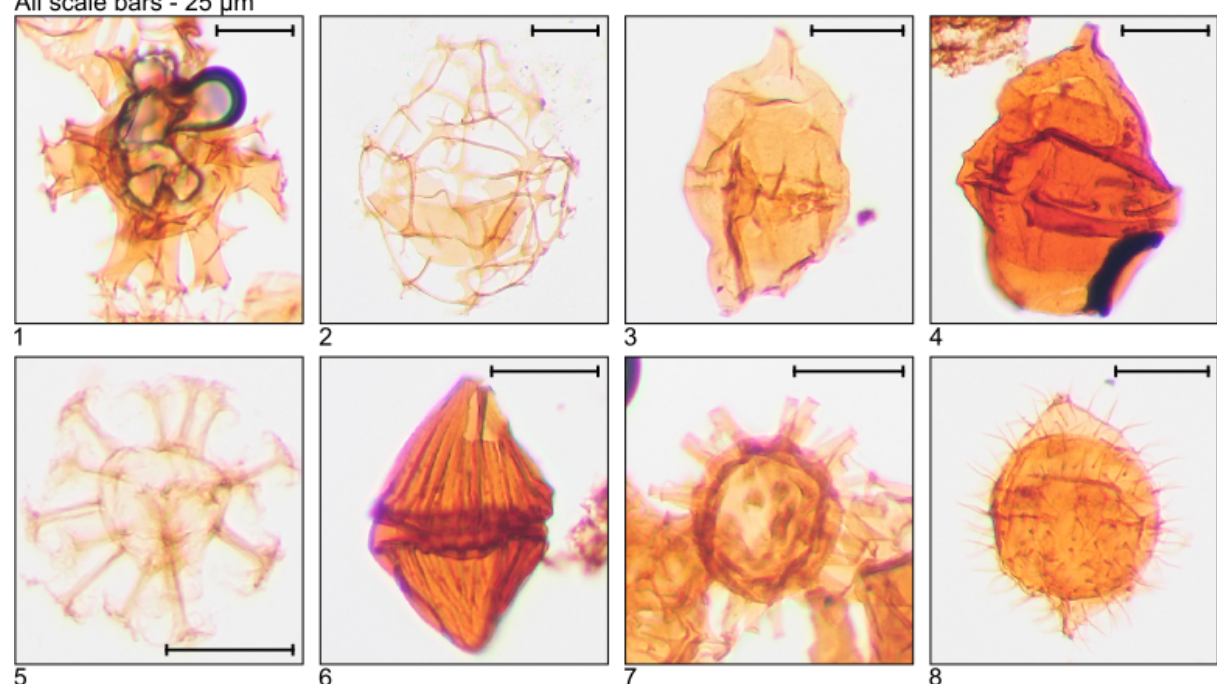
Plate 7. Illustration of reworked taxa and sample or slide number. (1) Achomosphaera ramulifera (MG363; 110.6m; C20). (2) Can- nosphaeropsis sp. (MG167; 50.9m; C20-1). (3, 4) Chatangiella sp. (MG283; 86.3m; D10-4; MG271; 82.6m; L19-3). (5) Cymososphaerid- ium? phoenix (MG167; 50.9m; C21-1). (6) Dinogymnium sibiricum (MG371; 113.1m; D18). (7) Litosphaeridium siphoniphorum (MG363; 110.6m; C17-2). (8) Palaeohystrichophora infusorioides (MG275; 83.8m;